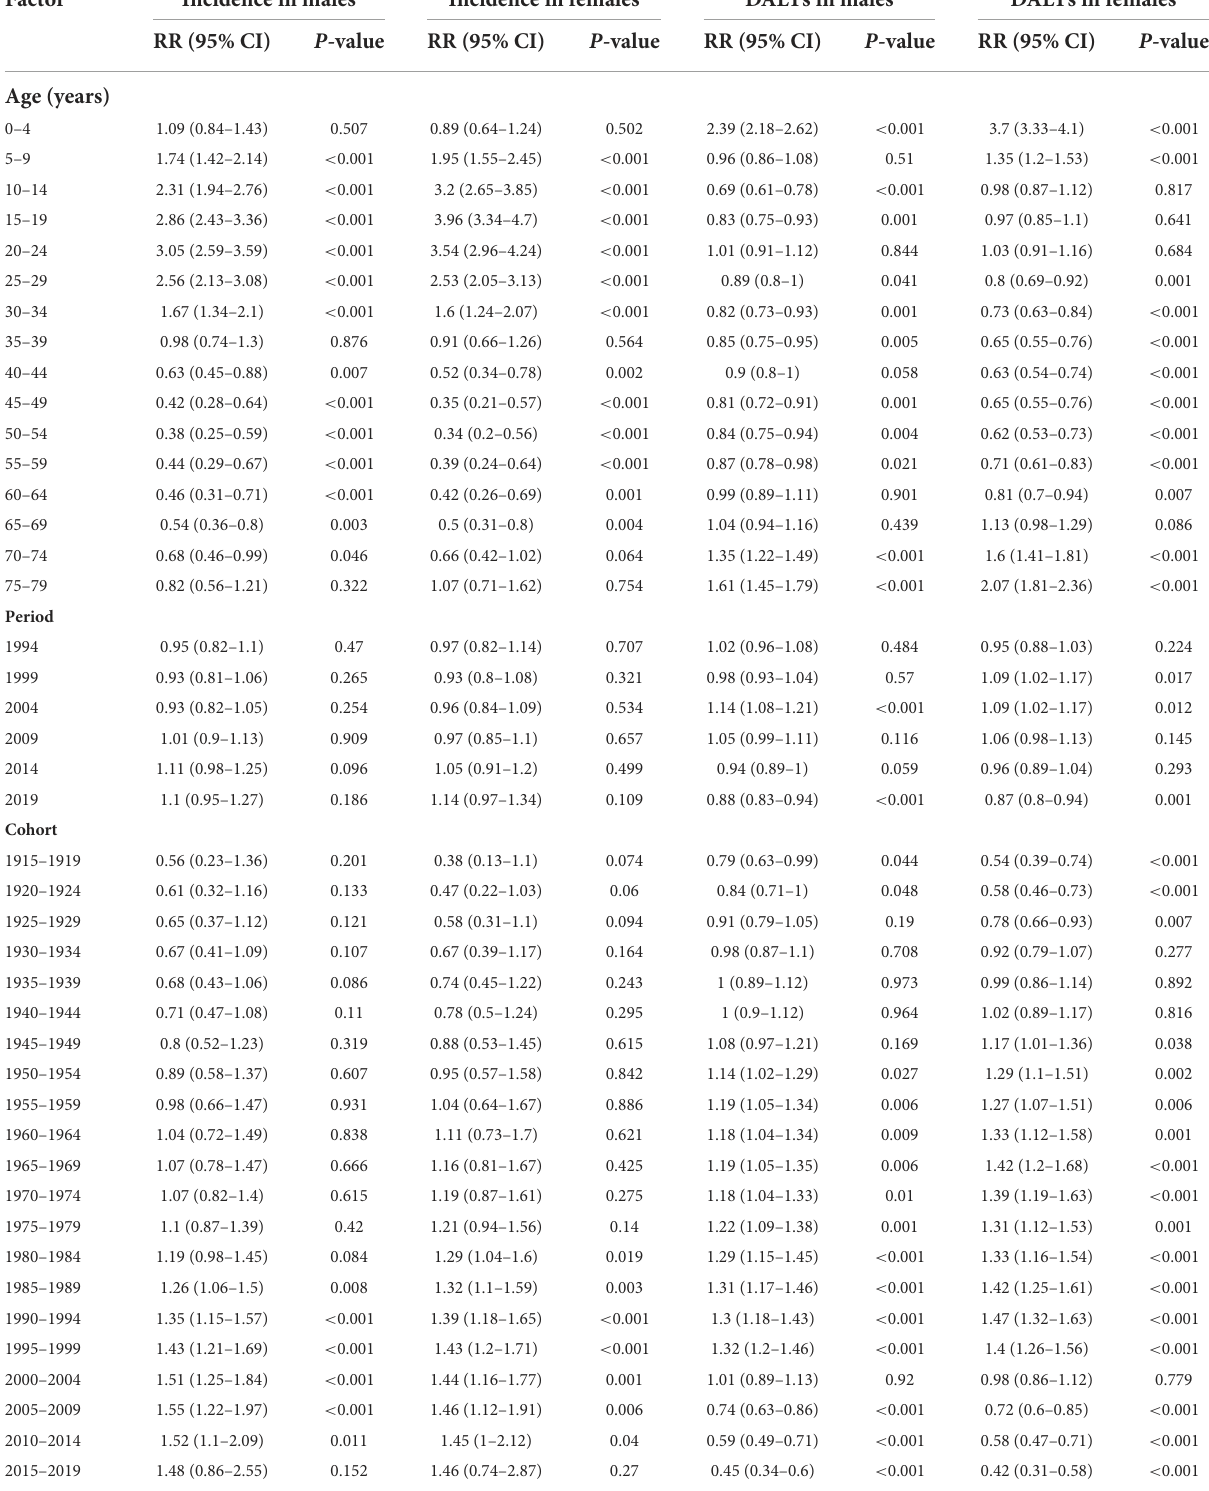
TABLE 2 Sex-specific relative risks of carbon monoxide poisoning and DALYs due to carbon monoxide poisoning in China due to age, period, and cohort effects. Factor Incidence in males Incidence in females DALYs in males DALYs in